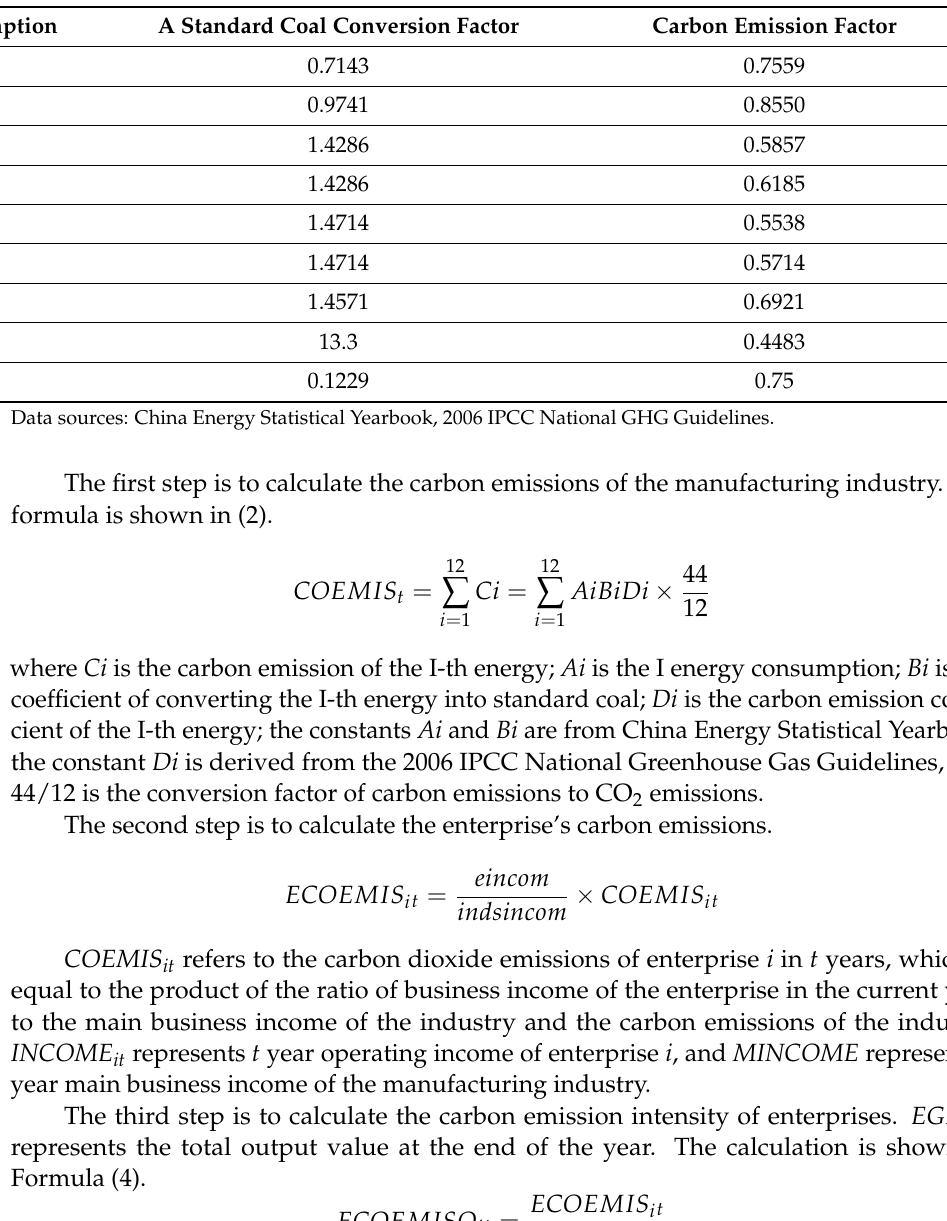
Table 1. Coal conversion and carbon emission coefficient of various energy